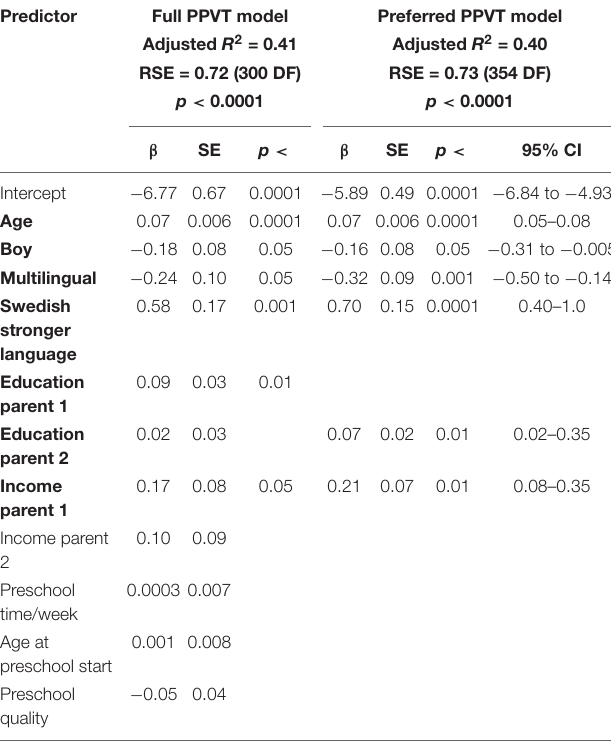
TABLE 3 | Model comparison for PPVT